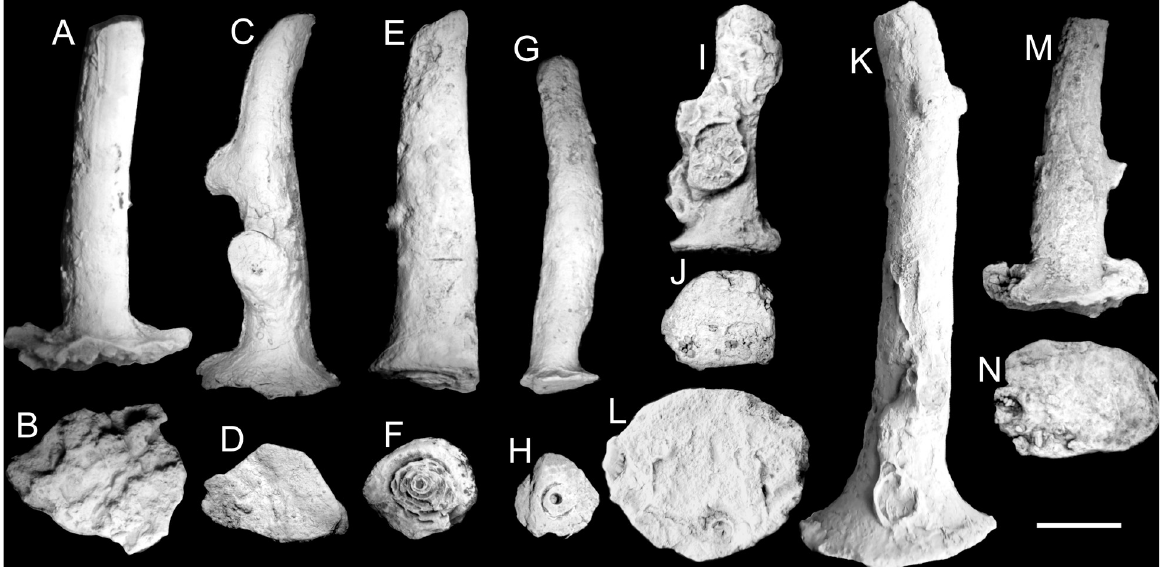
Fig 2. External view of studied juvenile specimens of Oligophylloides sp. (side and bottom view ordered respectively). A, B–specimen UAM/ He/B/011; C, D–specimen UAM/He/B/012; E, F–UAM/He/B/013; G, H–specimen UAM/He/B/014; I, J–specimen UAM/He/B/015; K, L– specimen UAM/He/B/016; M, N–UAM/He/B/21. Detailed explanations in the text. Scale bar 5 mm.